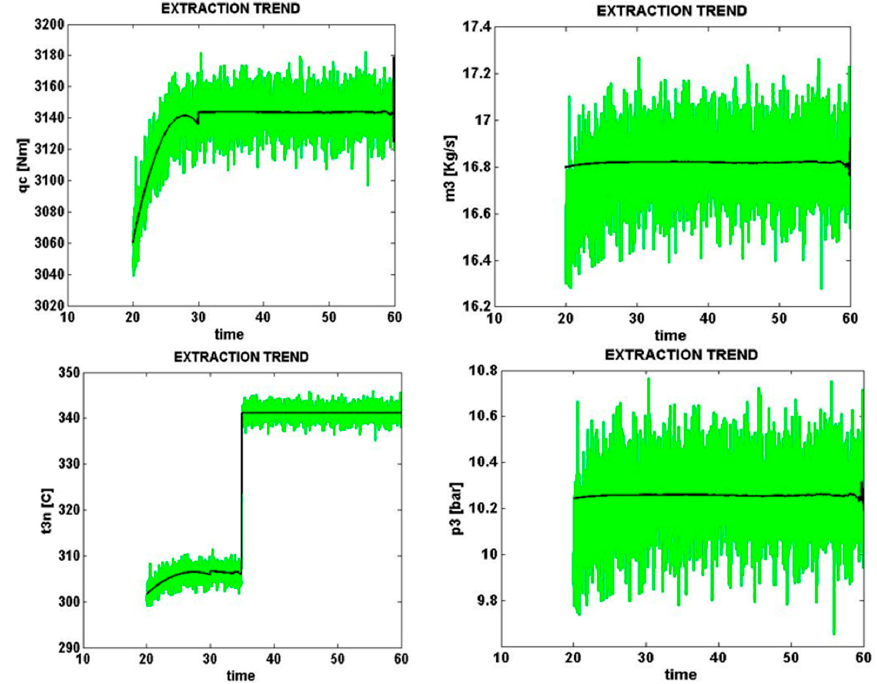
Figure 12. Error caused by a fault in the output voltage due to the occurrence of partial shadow by 20% error. 5.3. Solar Cell Damage and Lack of Partial Shade Solar cell signals sampled from four different parts of the solar cell with an e3 error (solar cell damage) with a normal level of zero percent are shown in Figure 13. The same condition with a high error level (+20%) is shown in Figure 13.